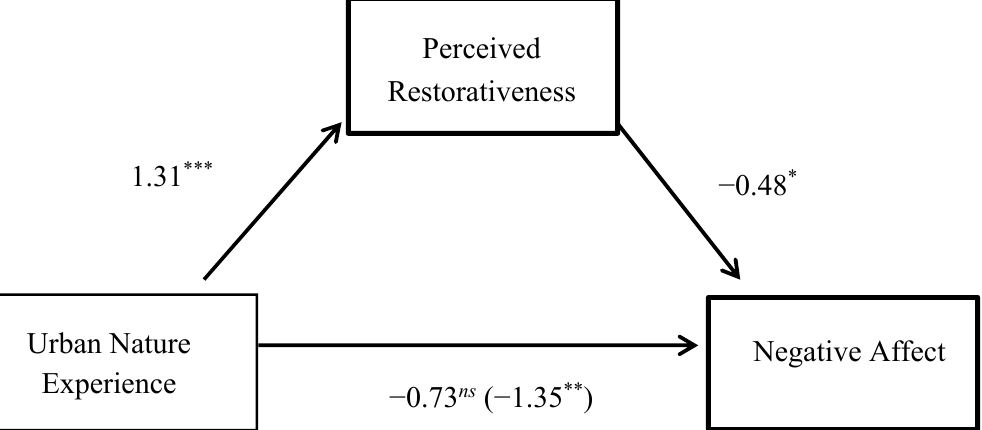
Figure 2 . Perceived restorativeness as a mediator of the relationship between the virtual urban nature experience and negative affect. All paths are unstandardized beta coefficients [39]. The value in parenthesis represents the relationship between the wild nature experience and positive affect prior to controlling for perceived restorativeness. N = 148, * p < 0.05, ** p < 0.01, *** p < 0.001, ns = not